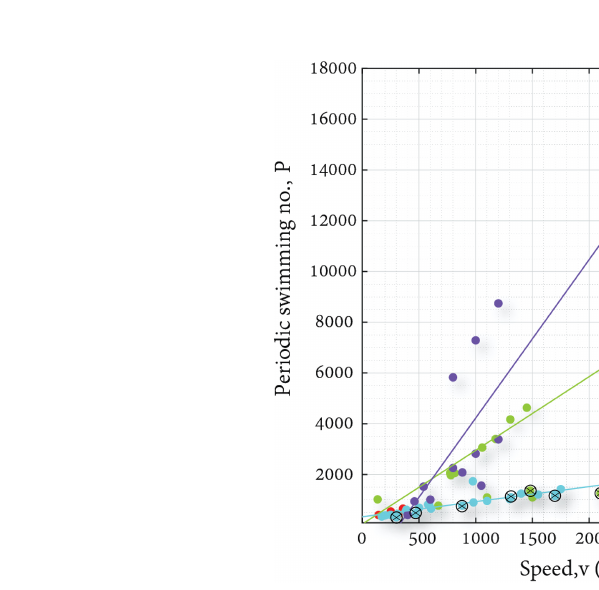
FIGURE 3 Periodic swimming number vs. speed (top) cluster based on mode of locomotion. Straight lines represent linear fi t for the different points. Open black circles with an internal cross correspond to data points where the oscillation frequency was estimated based on speed and length correlation provided by Webb et al.